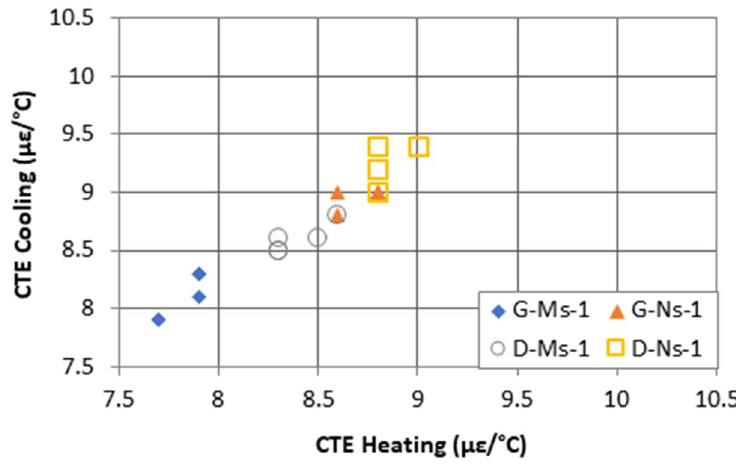
Figure 5. Effect of high volume of coarse aggregate and low volume of fine aggregate on concrete CTE .